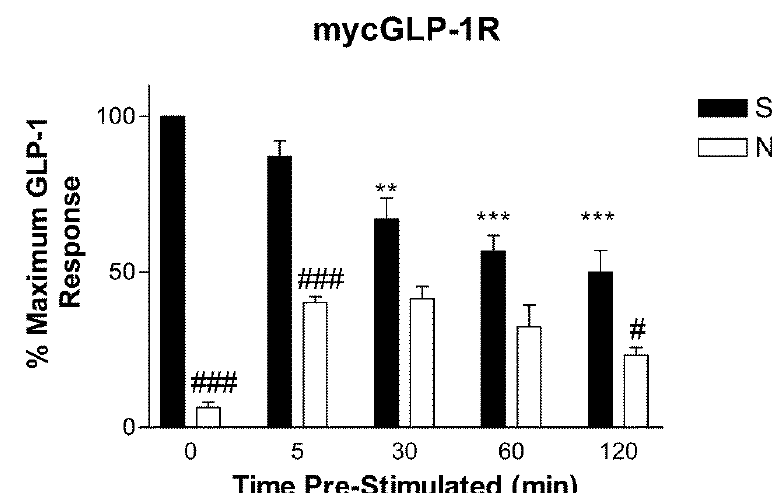
Figure 2. Desensitization of mycGLP-1R to a second stimulation with 1 µM GLP-1 following increasing periods of pre-stimulation with 1 µM GLP-1. Data are expressed as a percentage of maximum GLP-1 response and represent the mean, with the S.E.M. displayed as error bars from three independent experiments. ** p < 0.005, *** p < 0.001: GLP-1 response significantly different from control (no pre-stimulation). # p < 0.05, ### p < 0.001: Non-Stimulated significantly different the Stimulated following the same period of pre-stimulation.